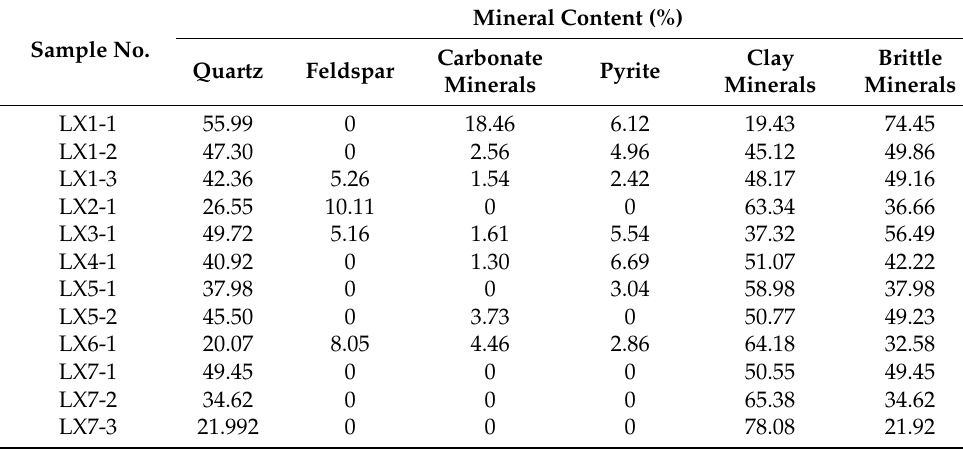
Table 2. Mineral compositions of the Taiyuan Formation shale.